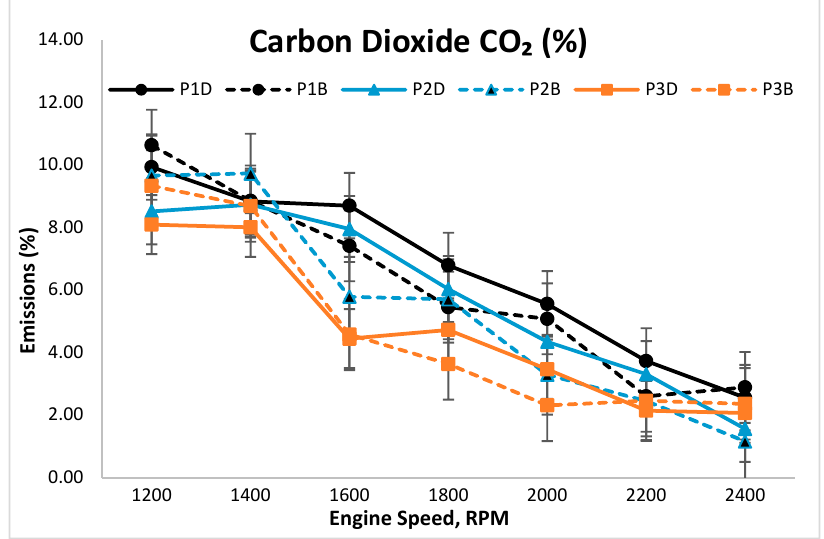
Figure 12. Carbon dioxide (CO 2 ) emissions at variable speeds.